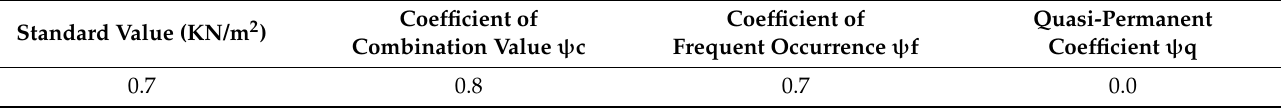
Table 3. Parameters of the average live load of the carport